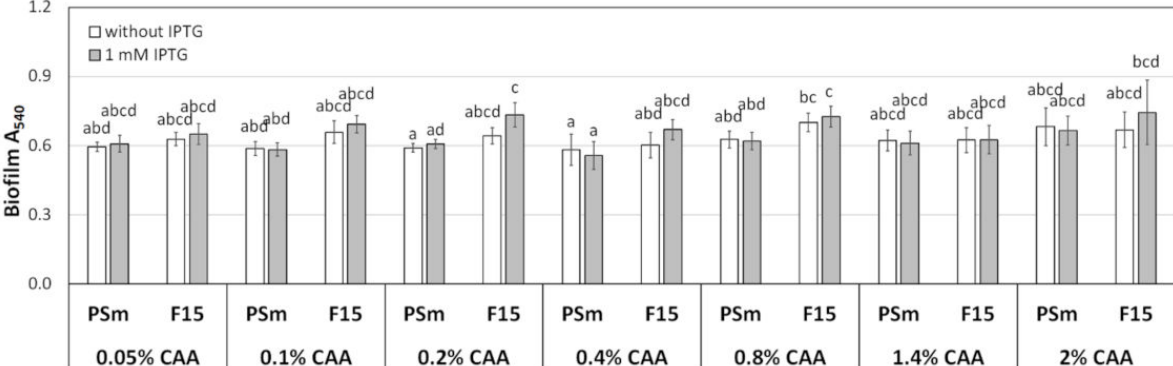
Figure 4. The biofilm of P. putida strains PSm and F15 in M9 media was amended with different amounts of CAA. The arithmetical averages of at least two independent measurement sets are shown. Brackets show the 95% confidence intervals, and the homogenous groups are shown above the columns by the lower-case letters. Identical letters denote non-significant differences ( p ≥ 0.05) between averages of biofilm.